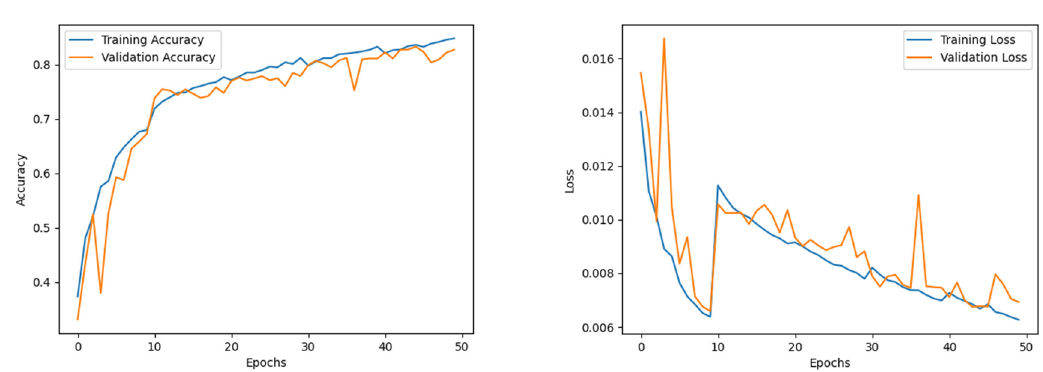
Figure 6. Accuracy and loss of Effimix model.